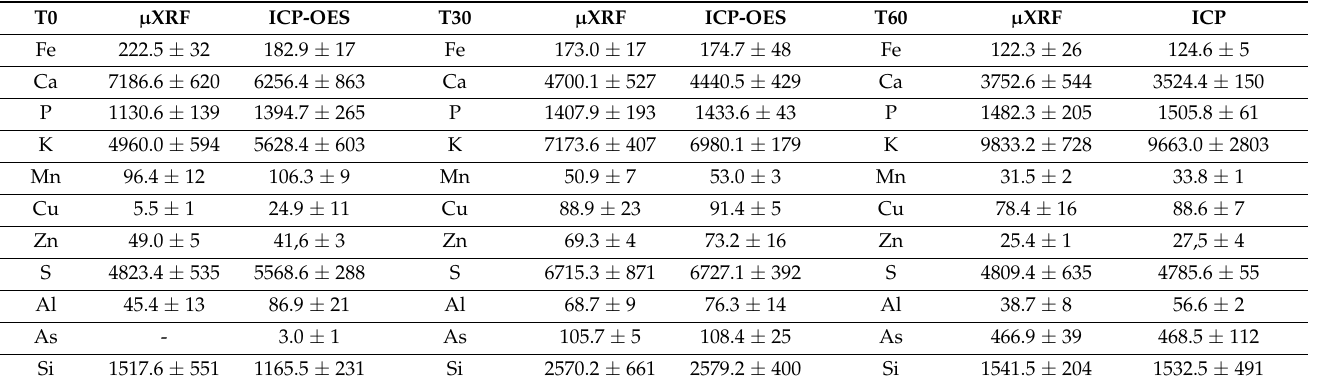
Table 2. Quantitative µ XRF and ICP–OES measurement of powder samples obtained from dried fronds of P. vittata grown in S1 soil at 0, 30 and 60 days. Results in mg/kg are expressed as the mean with its associated confidence interval.